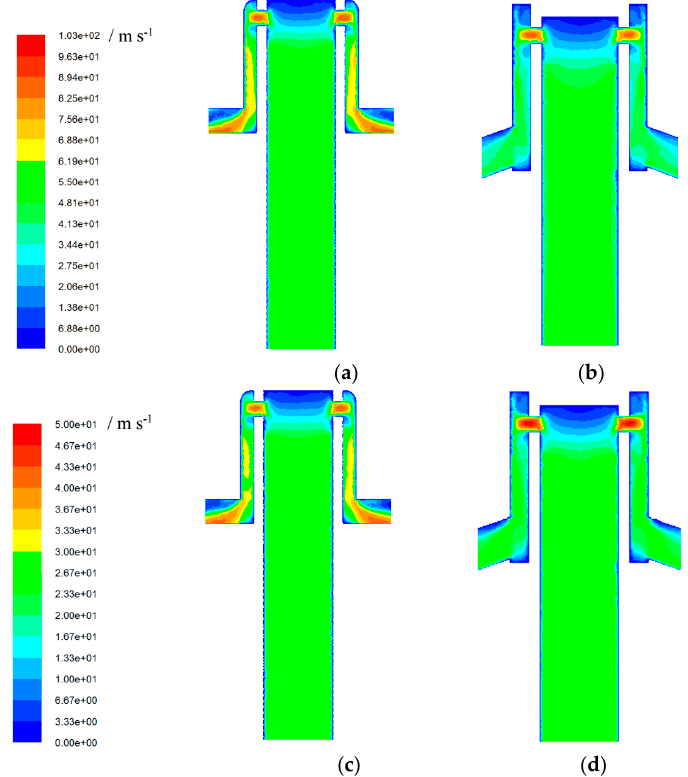
Figure 12. Velocity field in nozzle A and nozzle B. ( a ) nozzle A (100% load); ( b ) nozzle B (100% load); ( c ) nozzle A (30% load); ( d ) nozzle B (30% load).